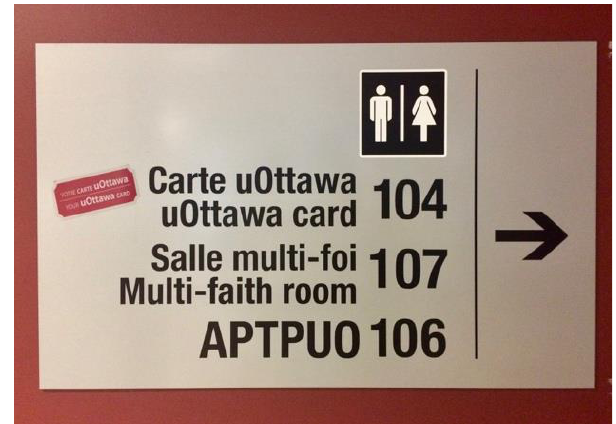
Figure 5. The sign to the multi-faith room in the Student Union Building.